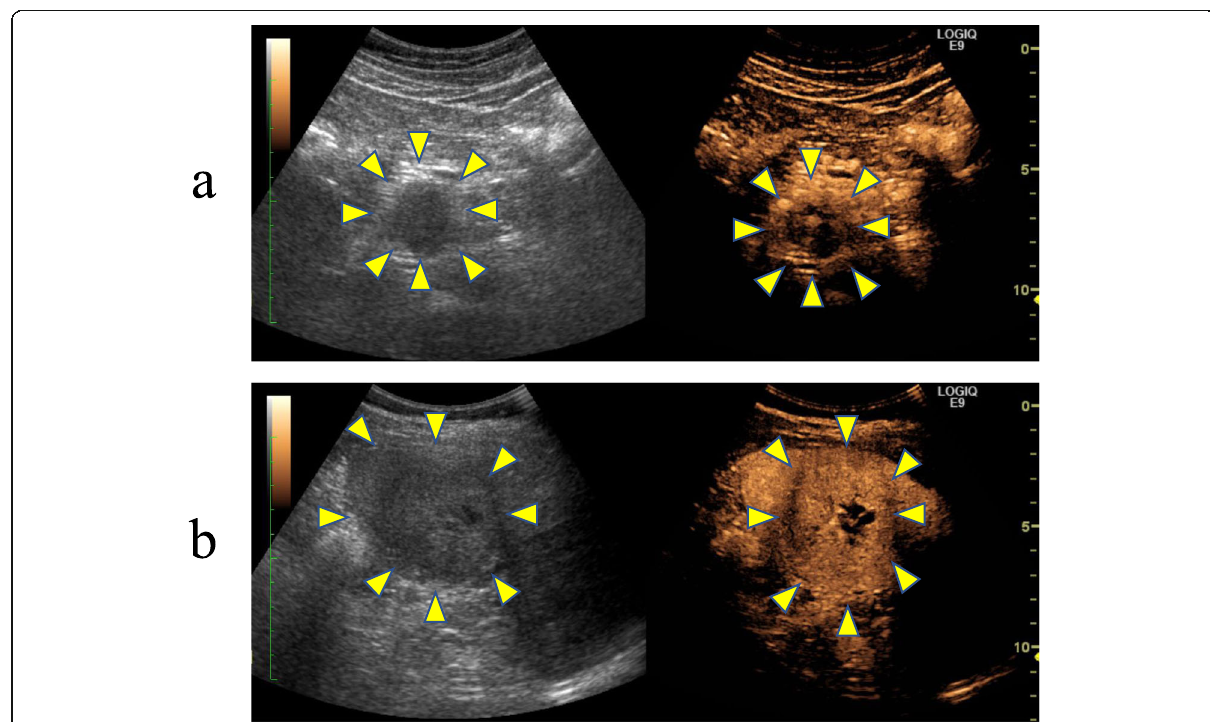
Fig. 1 Abdominal ultrasonography (US) with and without contrast. Abdominal US with and without contrast revealed the presence of isodense masses of 34 mm ( a ) in the pancreatic head and 60 mm and in the spleen ( b )